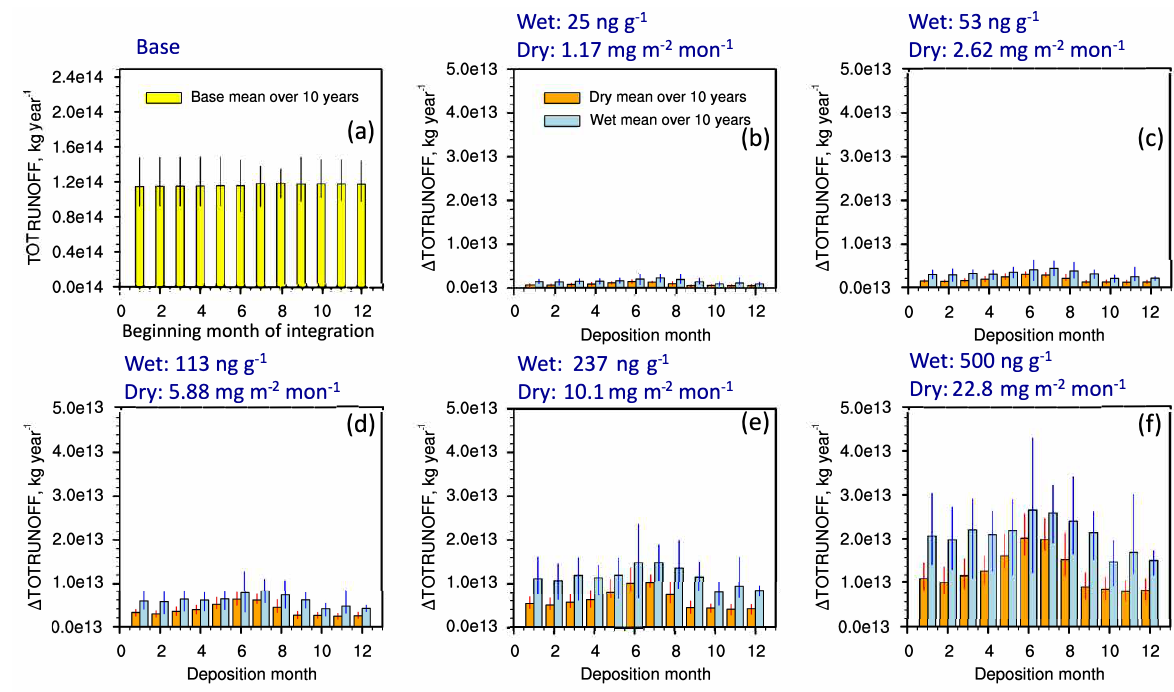
Figure 14. Total runoff in the base run without BC deposition (a) and the increase in total Greenland runoff resulting from BC deposition (b–f) , integrated over 1 year starting from the month of BC deposition. The bars show mean values and the whiskers depict the full range of values over all 10 simulations that each start in a different year from 2005 to 2016. Values of BC concentrations in precipitation and dry deposition fluxes are shown in the title of each plot (b–f) .